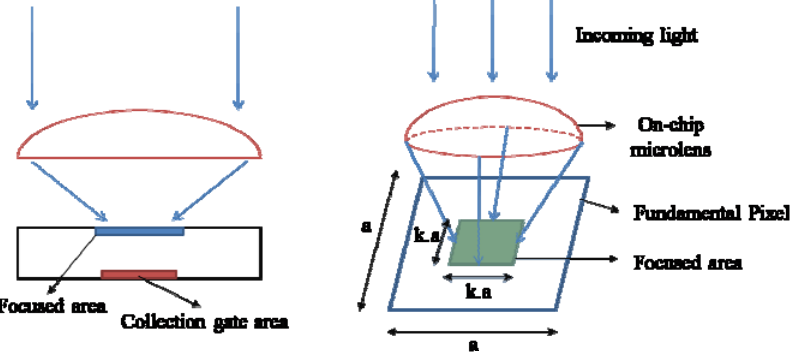
Figure 7. Function of on-chip micro-lens array concept (k is light collection